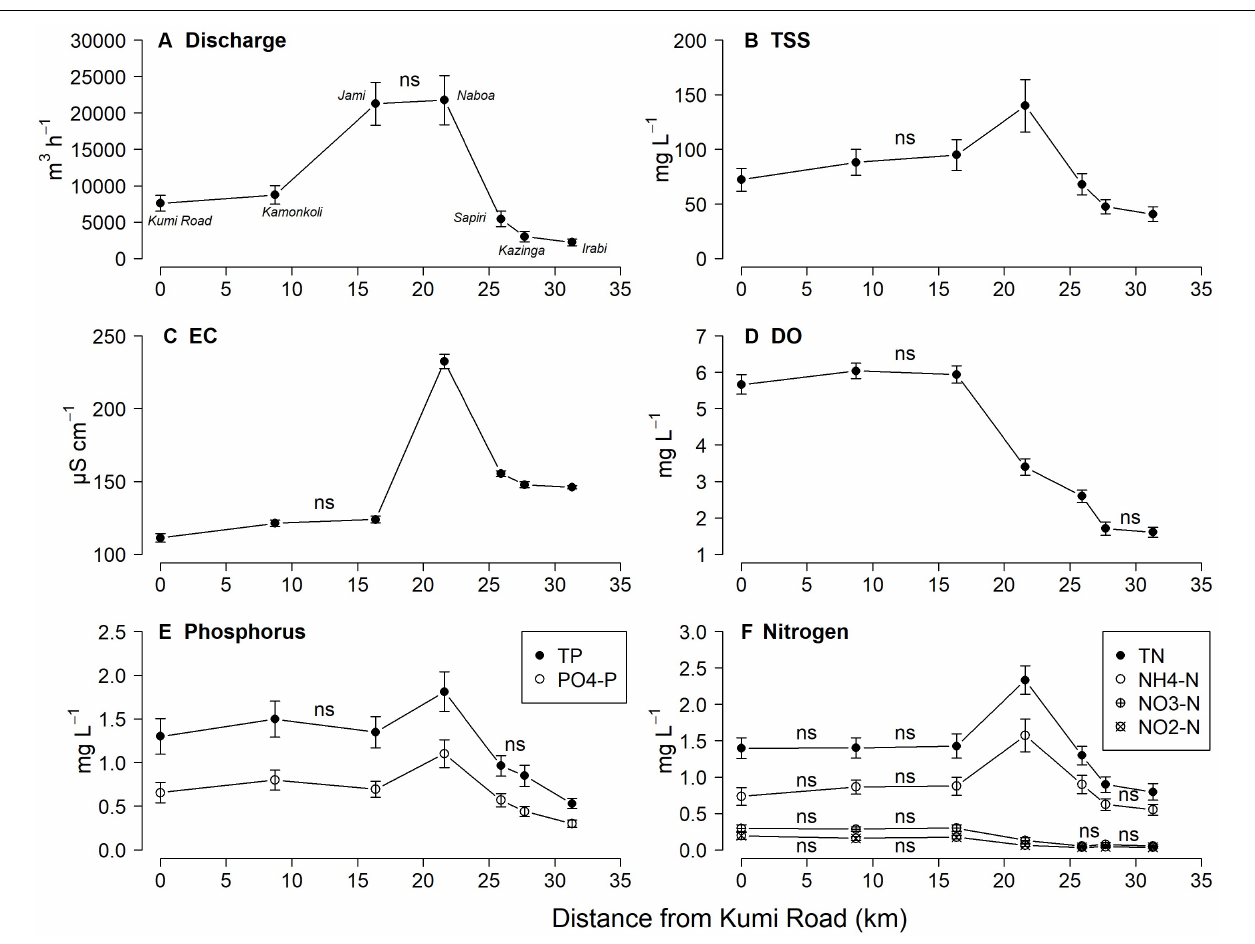
FIGURE 5 | Variation of discharge and water quality in the main channel of Namatala River from upstream to downstream for the period April 2015 – October 2016. (A) Discharge; (B) Total suspended solids (TSS); (C) Electrical conductivity (EC); (D) Dissolved oxygen (DO); (E) Total and soluble reactive phosphorus; (F) Total nitrogen, and ammonium, nitrate and nitrite nitrogen. Names of the sampling points are indicated in panel (A) . Data points are means of 19 monthly measurements; error bars indicate standard error. Differences between consecutive sampling points are significant (Wilcoxon signed rank test, P at least < 0.05) unless indicated by “ns” (not